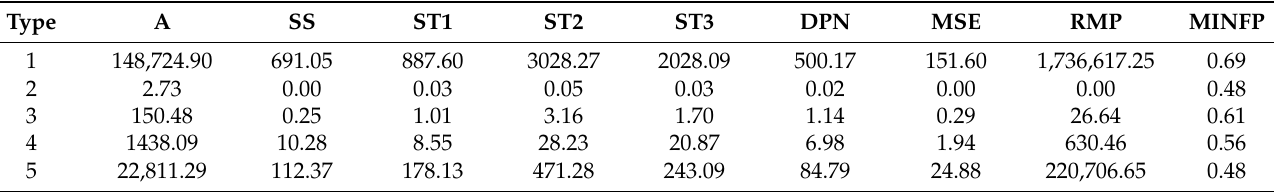
Table 2. Electricity characteristics in February.